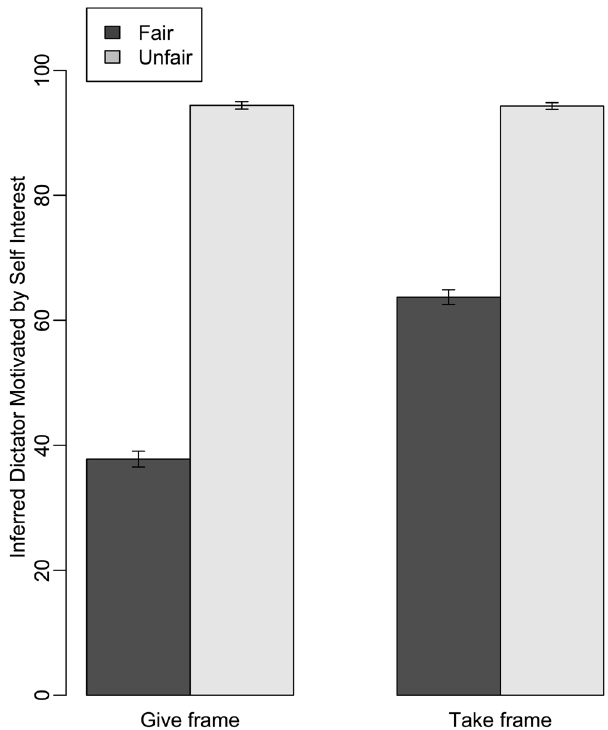
Figure 3. Attributions of self-interest for dictators as a function of the dictator’s decision and the game frame. Means and standard errors are generated from raw